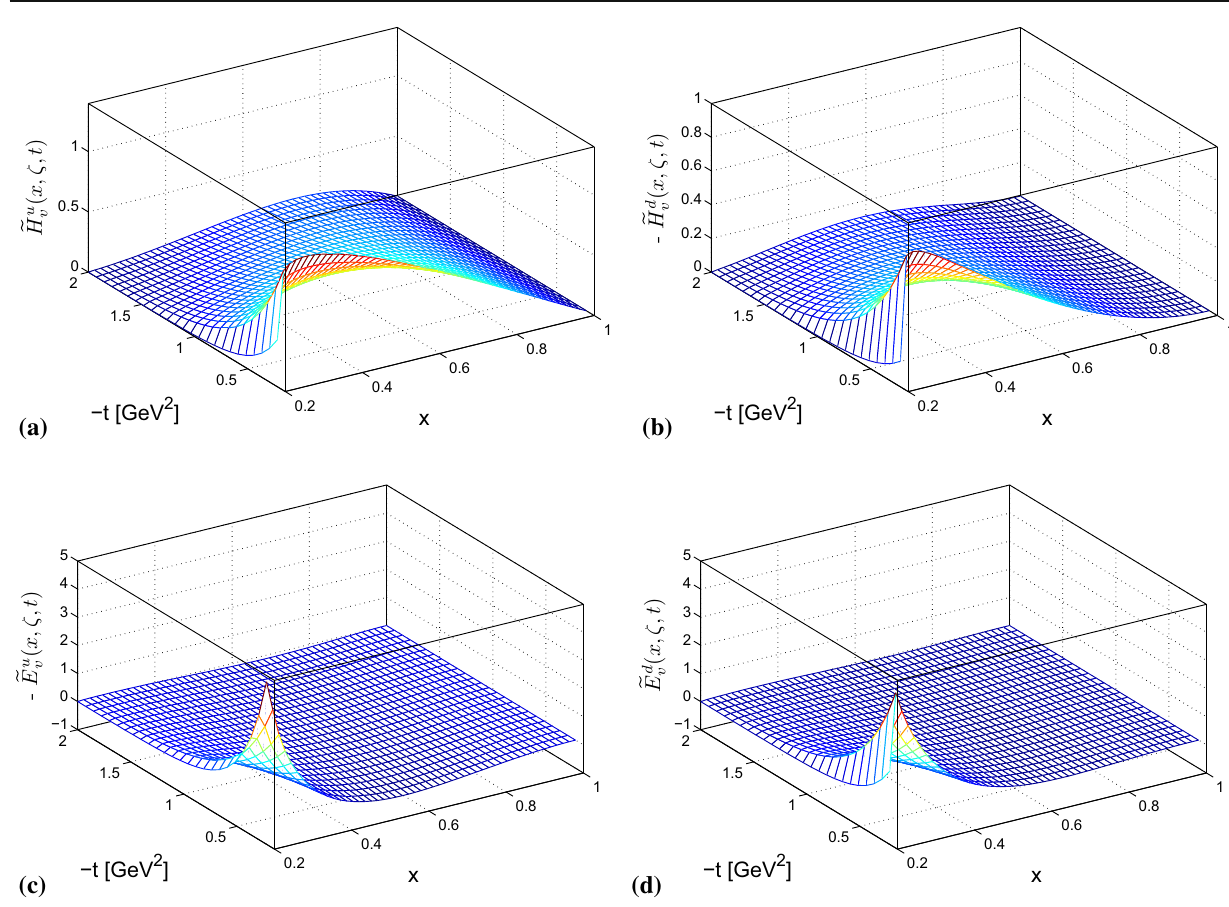
Fig. 1 (Color online) Plots of helicity-dependent GPDs for the nonzero skewness as functions of x and − t , and for a fixed value of ζ = 0 . 2. a (cid:2) H u (cid:2) H d (cid:2) E u (cid:2) E d ζ = 0 . 2 the minimum value of − t = − t v , b v and c v , d v ; for